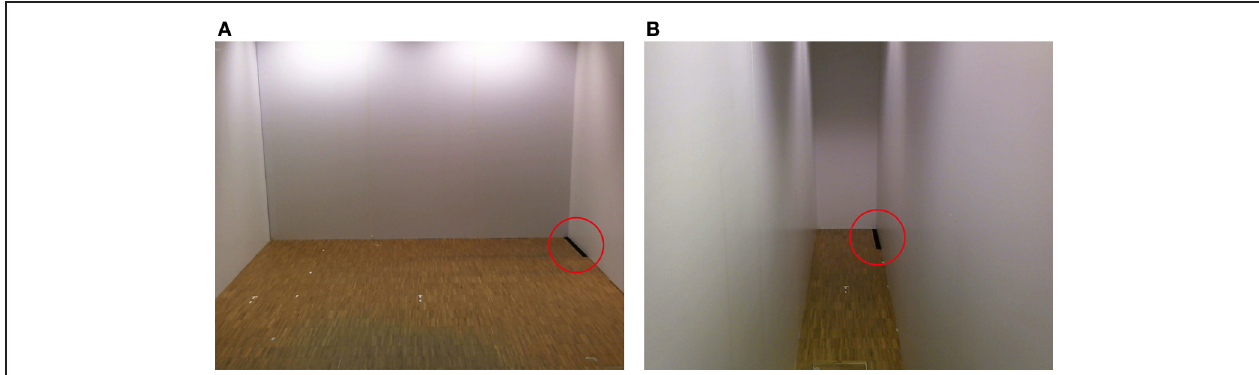
FIGURE 2 | Stimuli for length estimation presented in perspective. The stimuli of the length estimation task (black bars) as presented on the HMD after each block of the FBI for the two interiors. The bars were presented in perspective along the sidewalls of the large (A) and narrow room (B) .